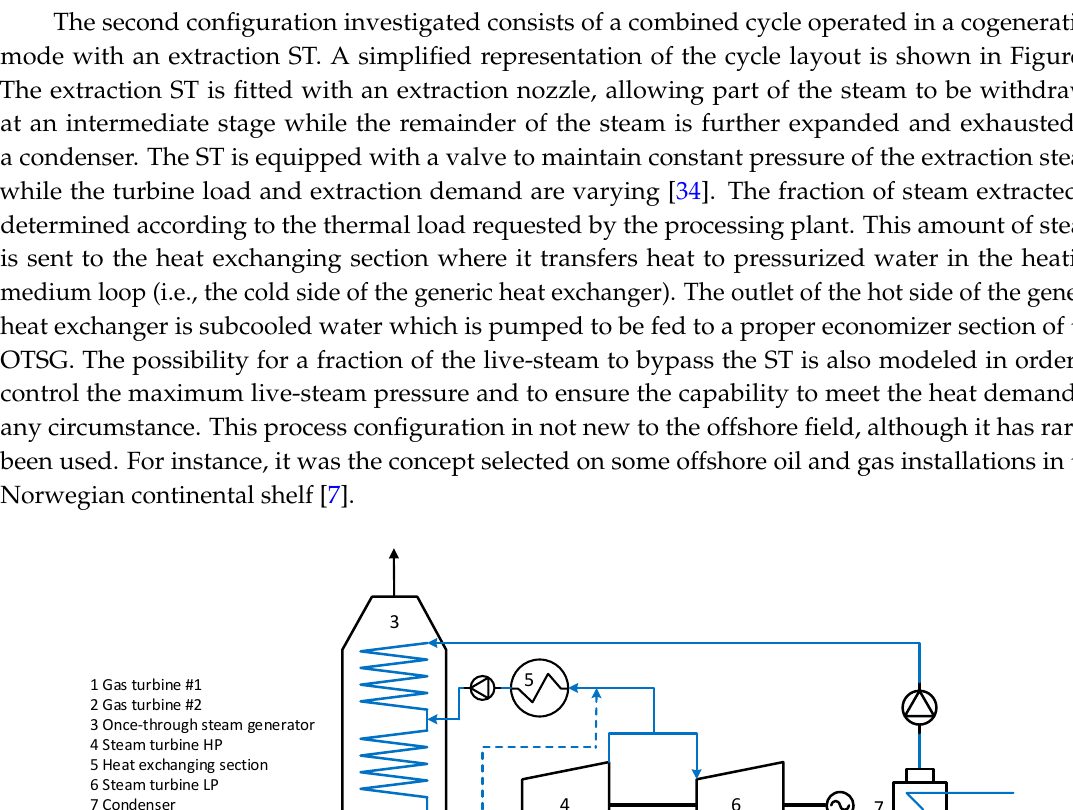
Table 6. Overview of all the designs defined for the extraction steam turbine cycle.